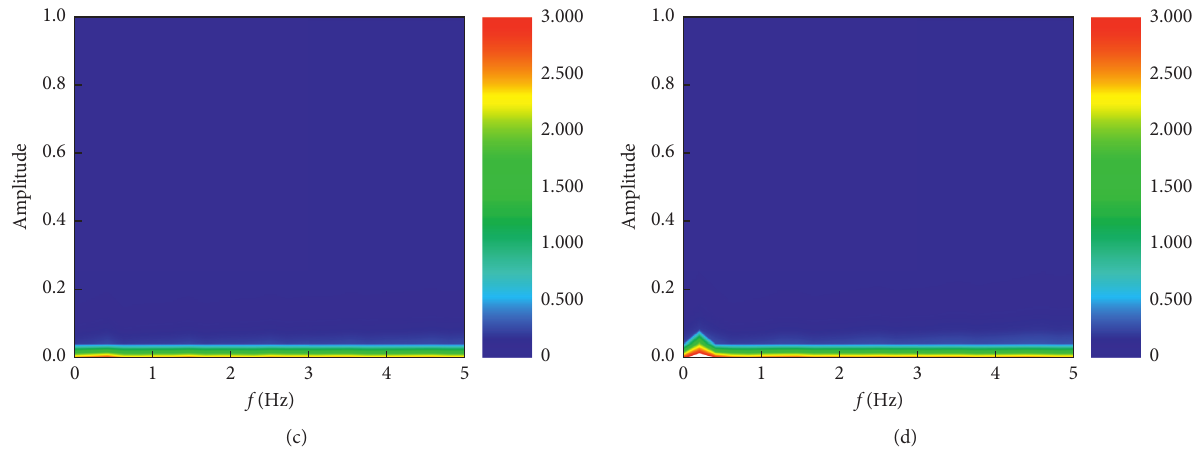
The decomposition effect of signal 2 under different parameters.